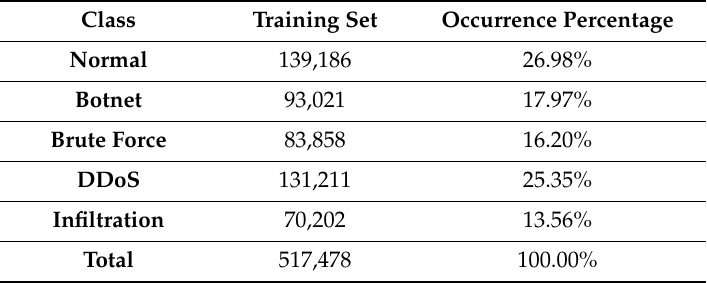
Table 2. Number of samples for normal and attack classes.